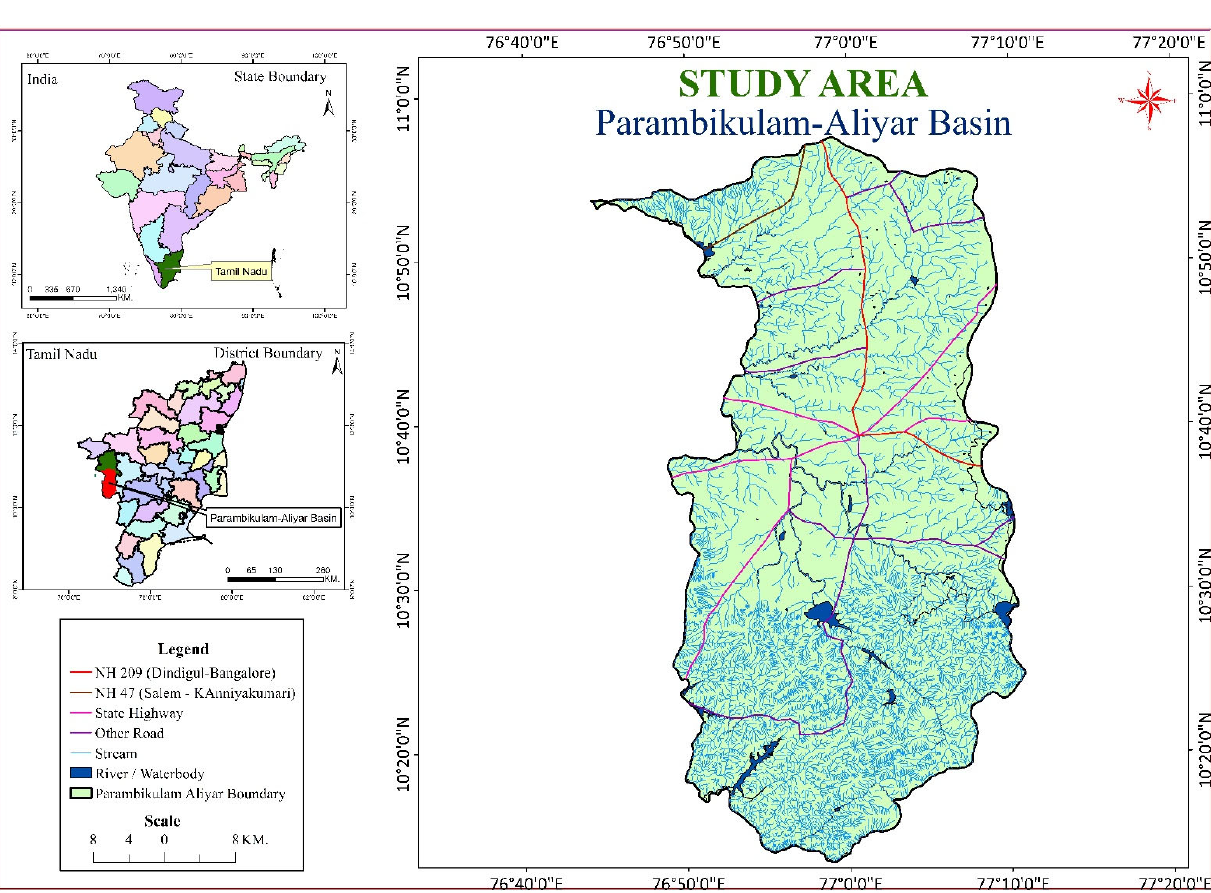
Figure 4. Location map of the Parambikulam–Aliyar Basin.